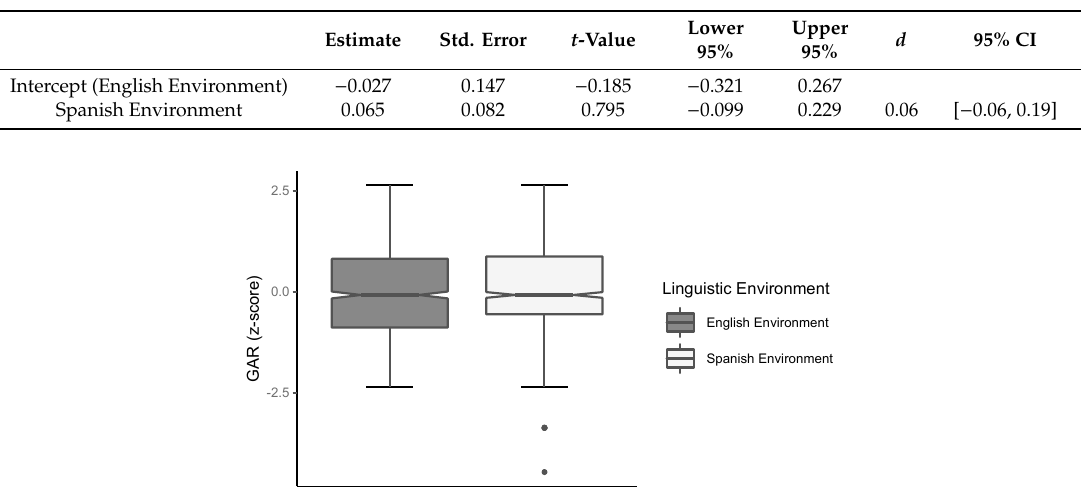
Table 4. Global Accent Rating Model Fixed Effects.